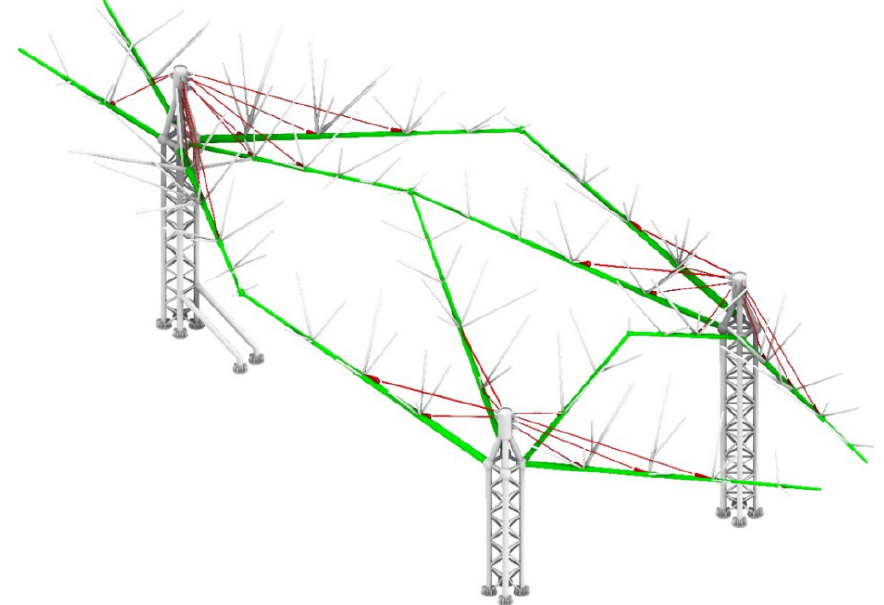
Figure 5. Asymmetric umbrella-shaped structure.